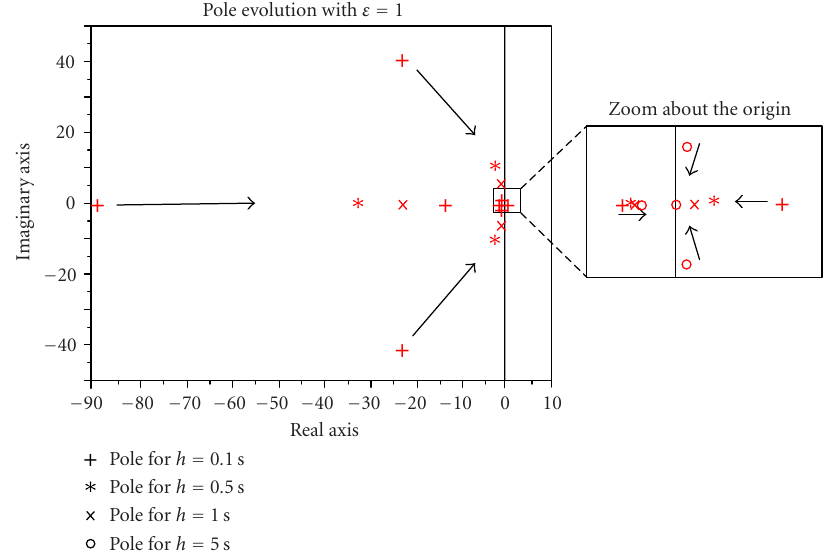
Figure 5.3. Third-order Pade’s approximation: the arrows show the pole motion as the delay h in- creases for ε = 1.